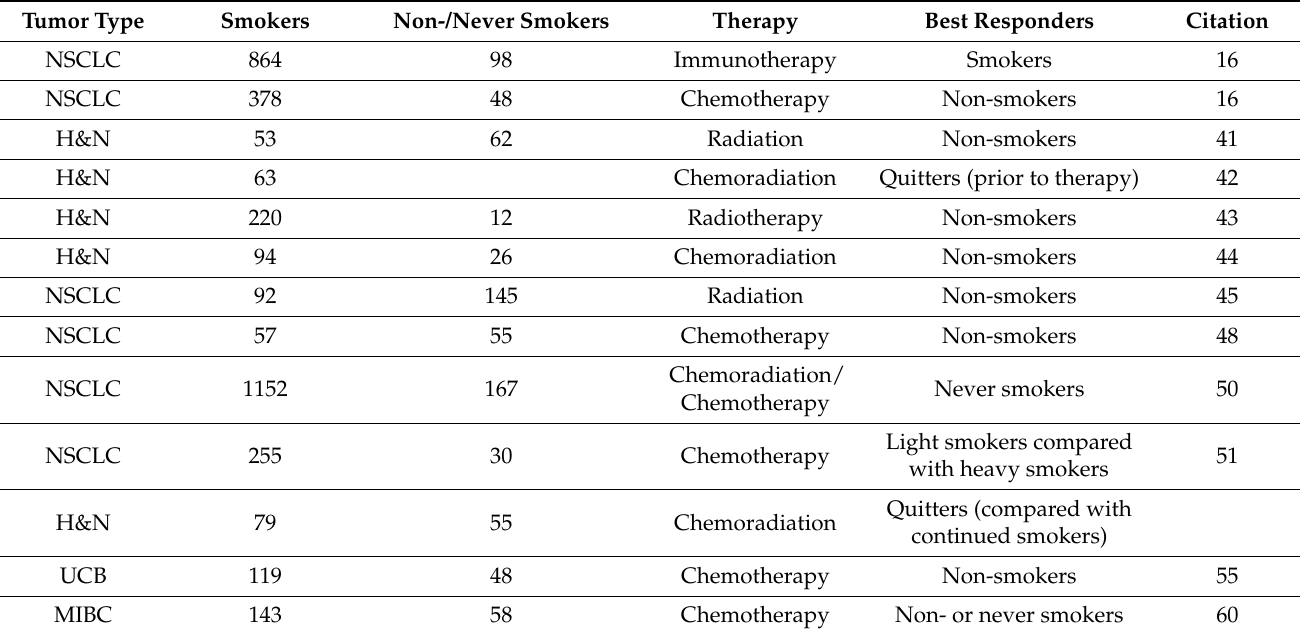
Table 1. Summary of the major findings on smoking status and therapy response in cancer